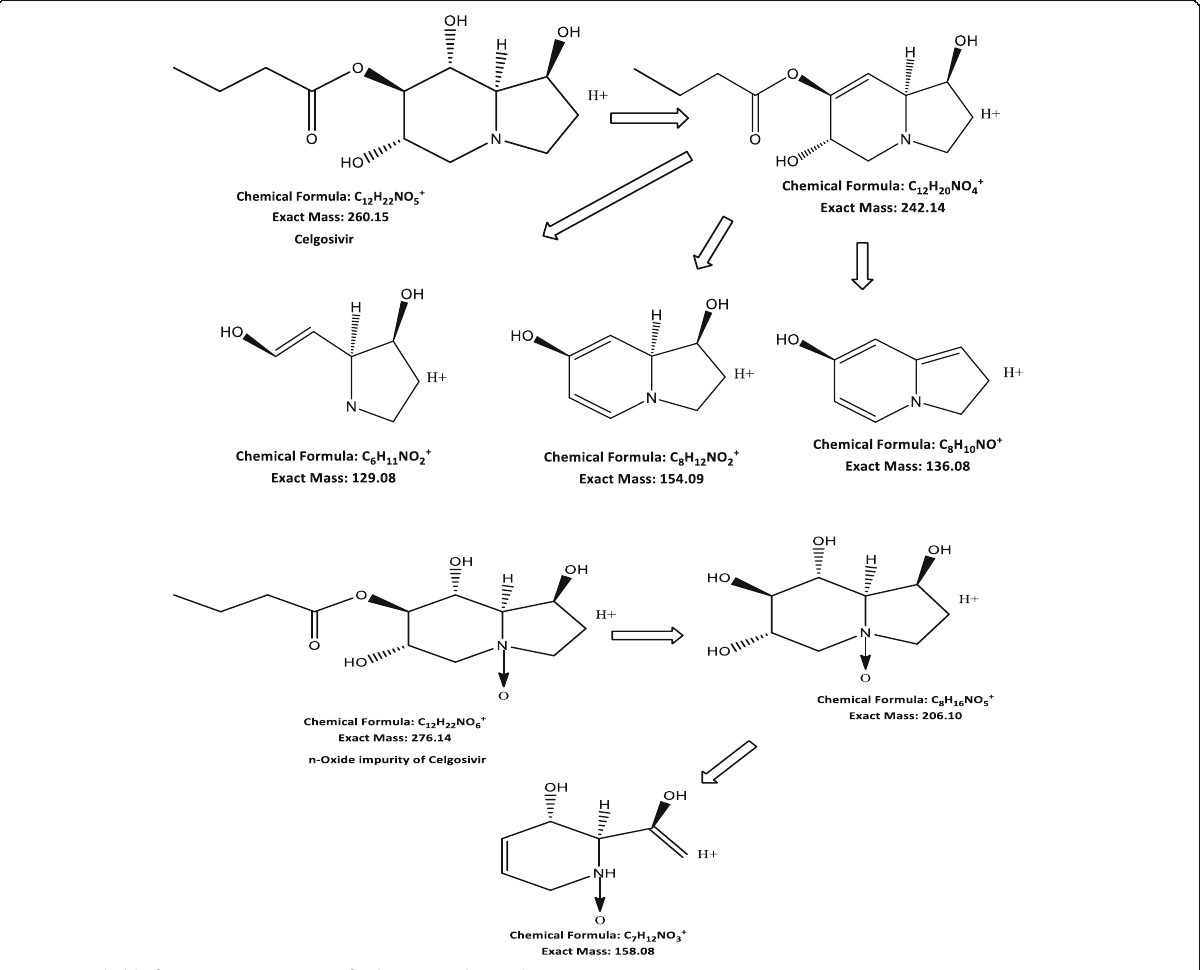
Fig. 12 Probable fragmentation pattern of celgosivir and n-oxide